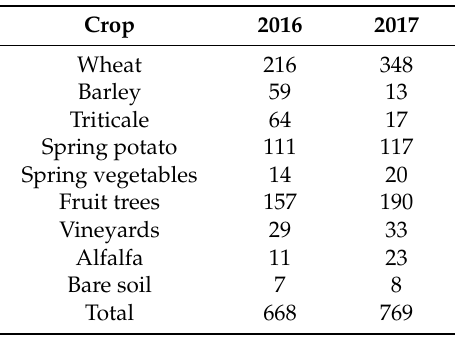
Table 2. Number of segmented plots visited per cultivations in 2016 and